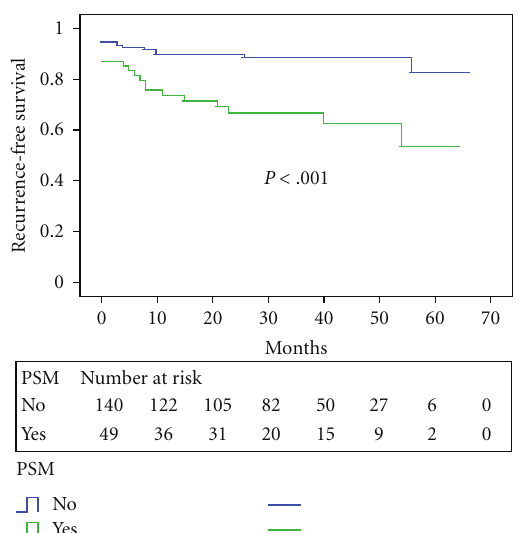
Figure 5: PSA recurrence-free survival stratified by surgical margin status.